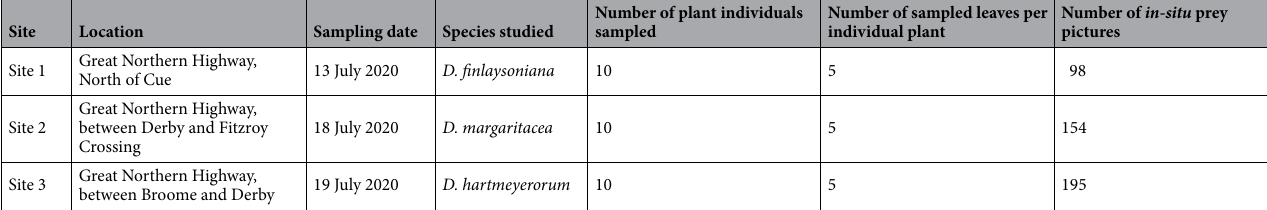
Table 1. Summary of the three study sites in Western